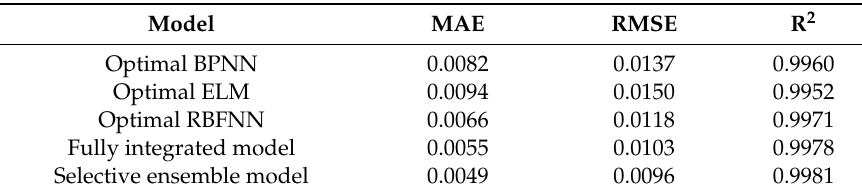
Table 8. Prediction performance data of five models (Testing